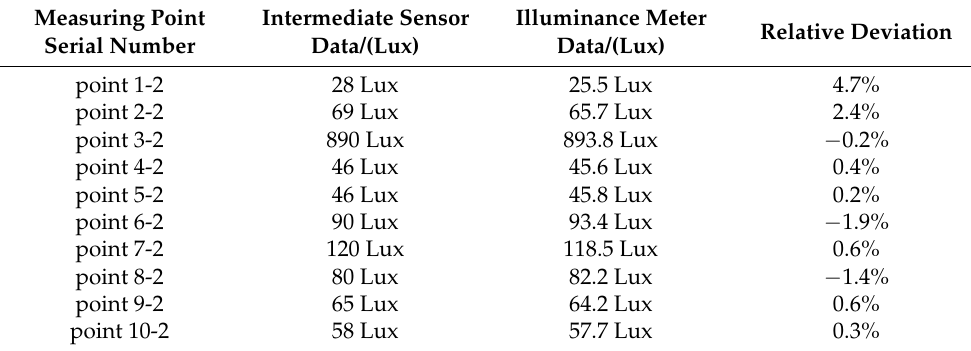
Table 2. Data comparison table of intermediate illuminance sensor and illuminometer.